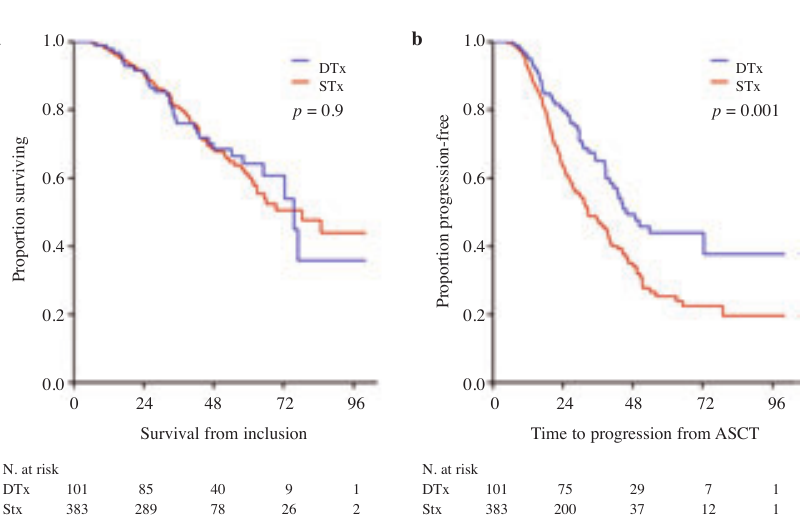
Figure 1. Overall survival (a) and progression free survival (b) following double trans- plantation in trial HKTH (N=101), compared to single transplantation in NMSG